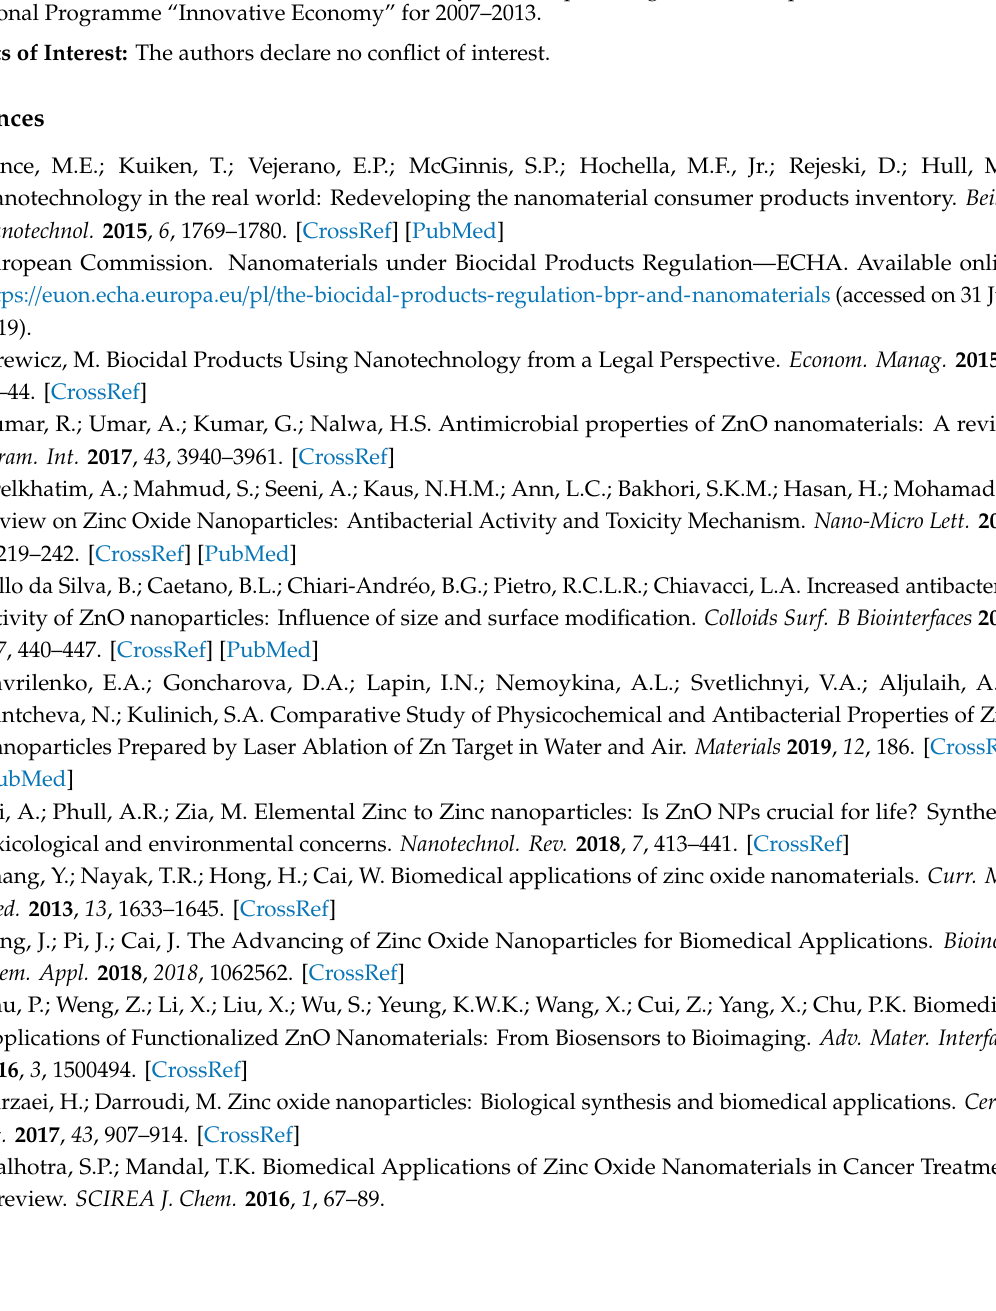
Figure S1: X-ray di ff raction pattern of ZnO-NPs, Table S1: Characteristics of